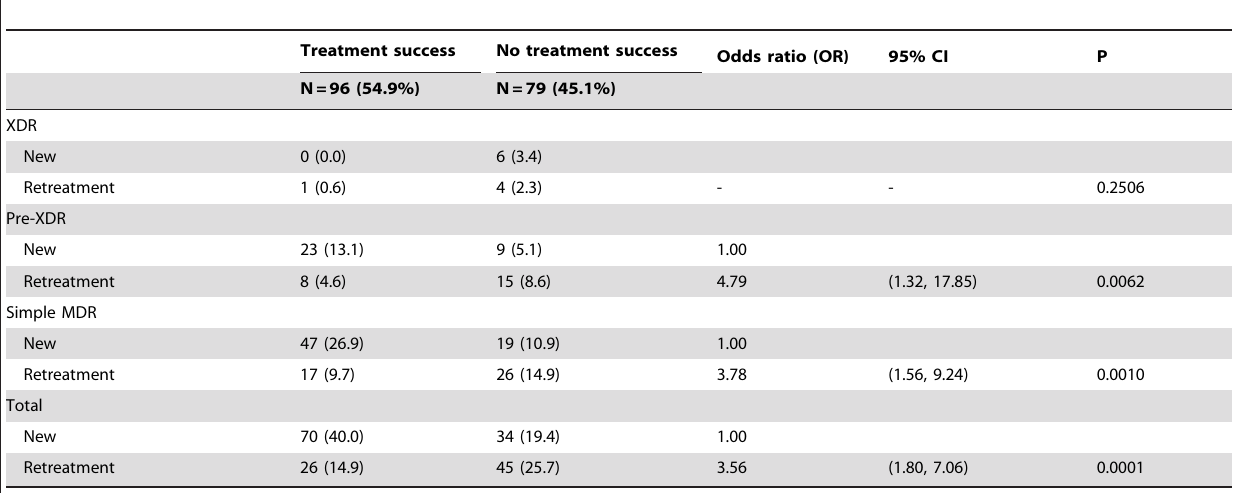
Table 3. Treatment outcomes among tuberculosis (TB) patients with simple MDR TB, pre-XDR TB and XDR TB, stratified by new cases versus previously treated